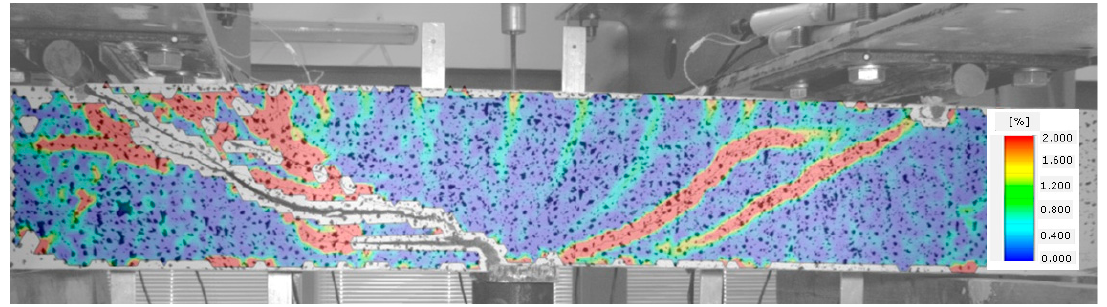
Figure 12. Stage IV of shear behavior of element—stabilization of the diagonal crack and arriving at the shear capacity.